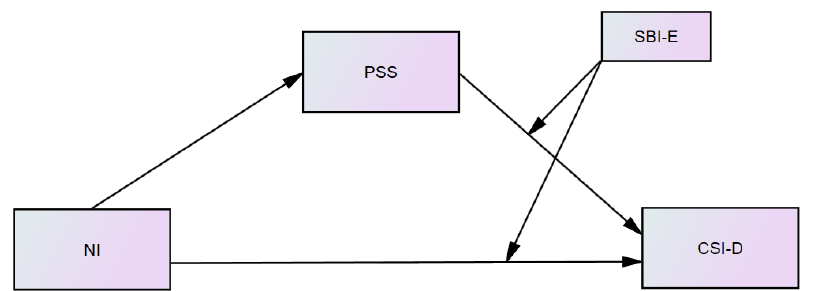
Figure 4. Final moderated mediation model (Model 15).